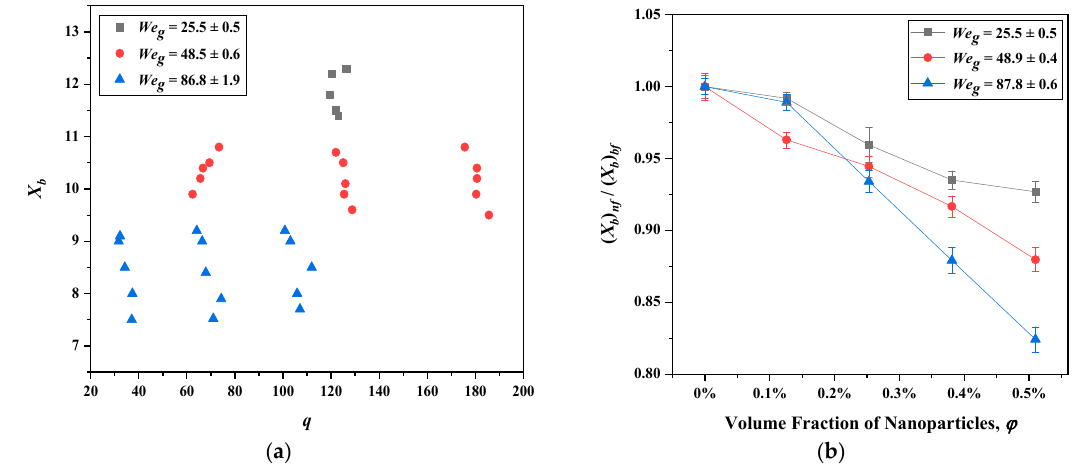
Figure 13. X -positions of column fracture in di ff erent cases: ( a ) Di ff erent We g and q ; ( b ) Di ff erent We g and ϕ